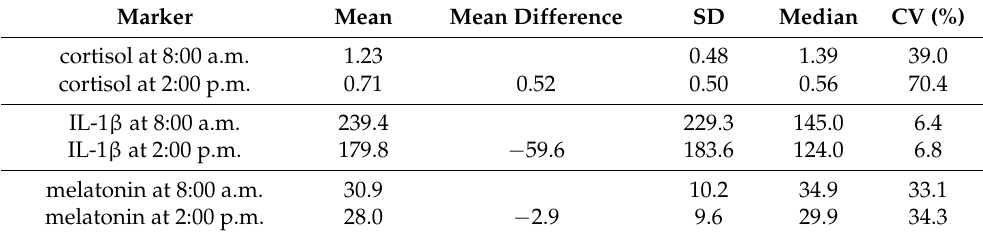
Table 2. Descriptive statistical data about salivary markers levels.